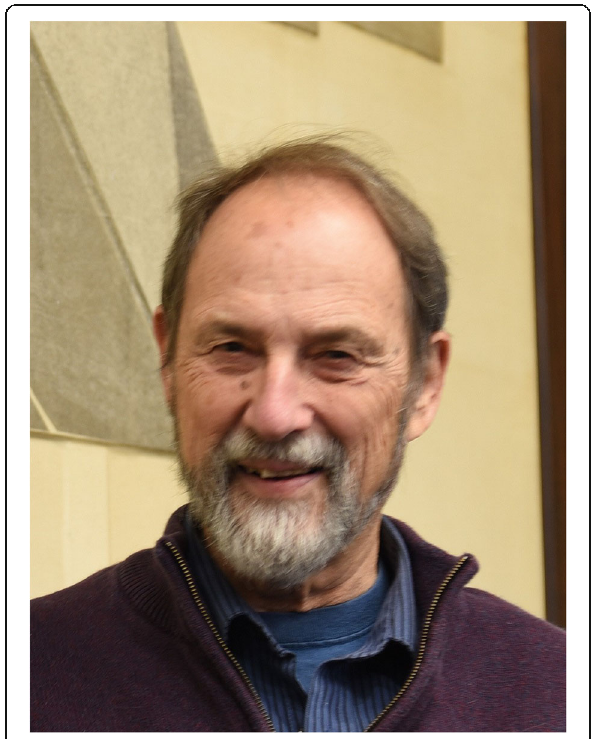
Fig. 27 David W. Malloch. Photo: Wen